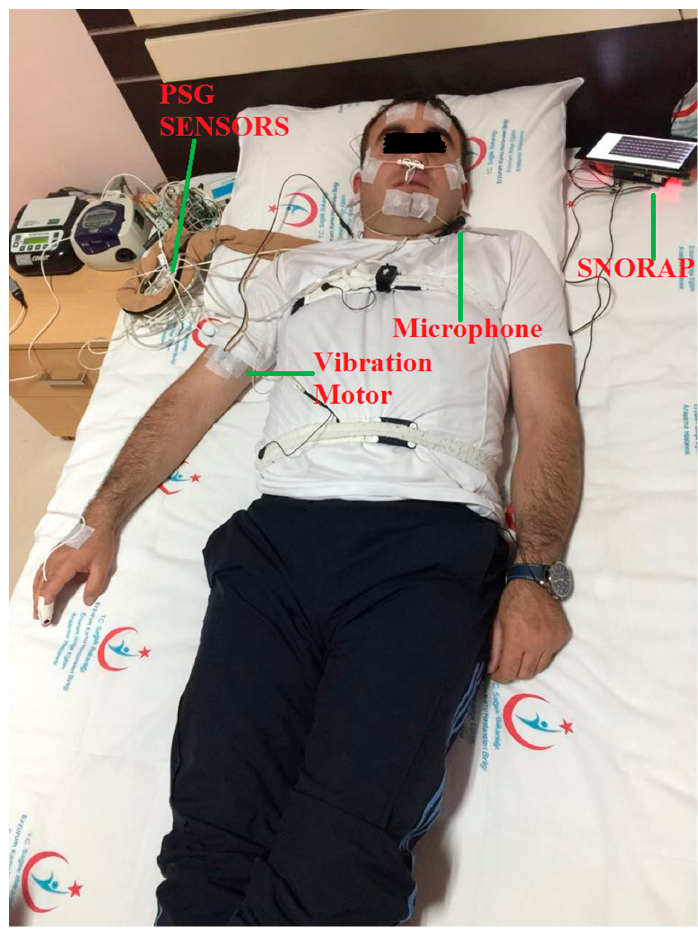
Figure 6. Polysomnography and SNORAP practice during a night in a sample patient.